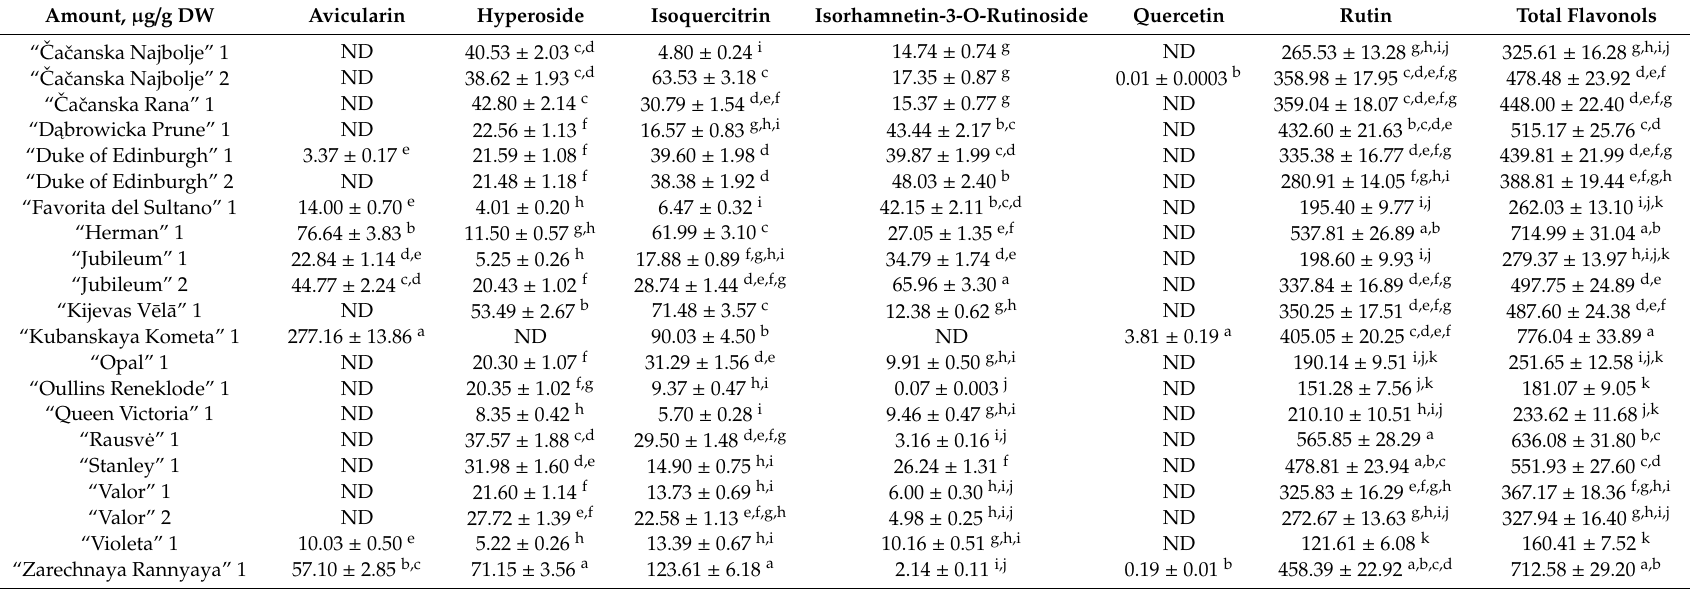
Table 1. Variability in the quantitative content ( µ g / g DW) of identified flavonols in plum fruit samples. The di ff erent letters indicate statistically significant ( p < 0.05) di ff erences between the quantitative values of flavonols in plum fruit samples of di ff erent cultivars. 1—“Myrobalan” ( P. cerasifera Ehrh.) rootstock; 2—“Wangenheim Prune” ( P. domestica L.) rootstock. ND—not